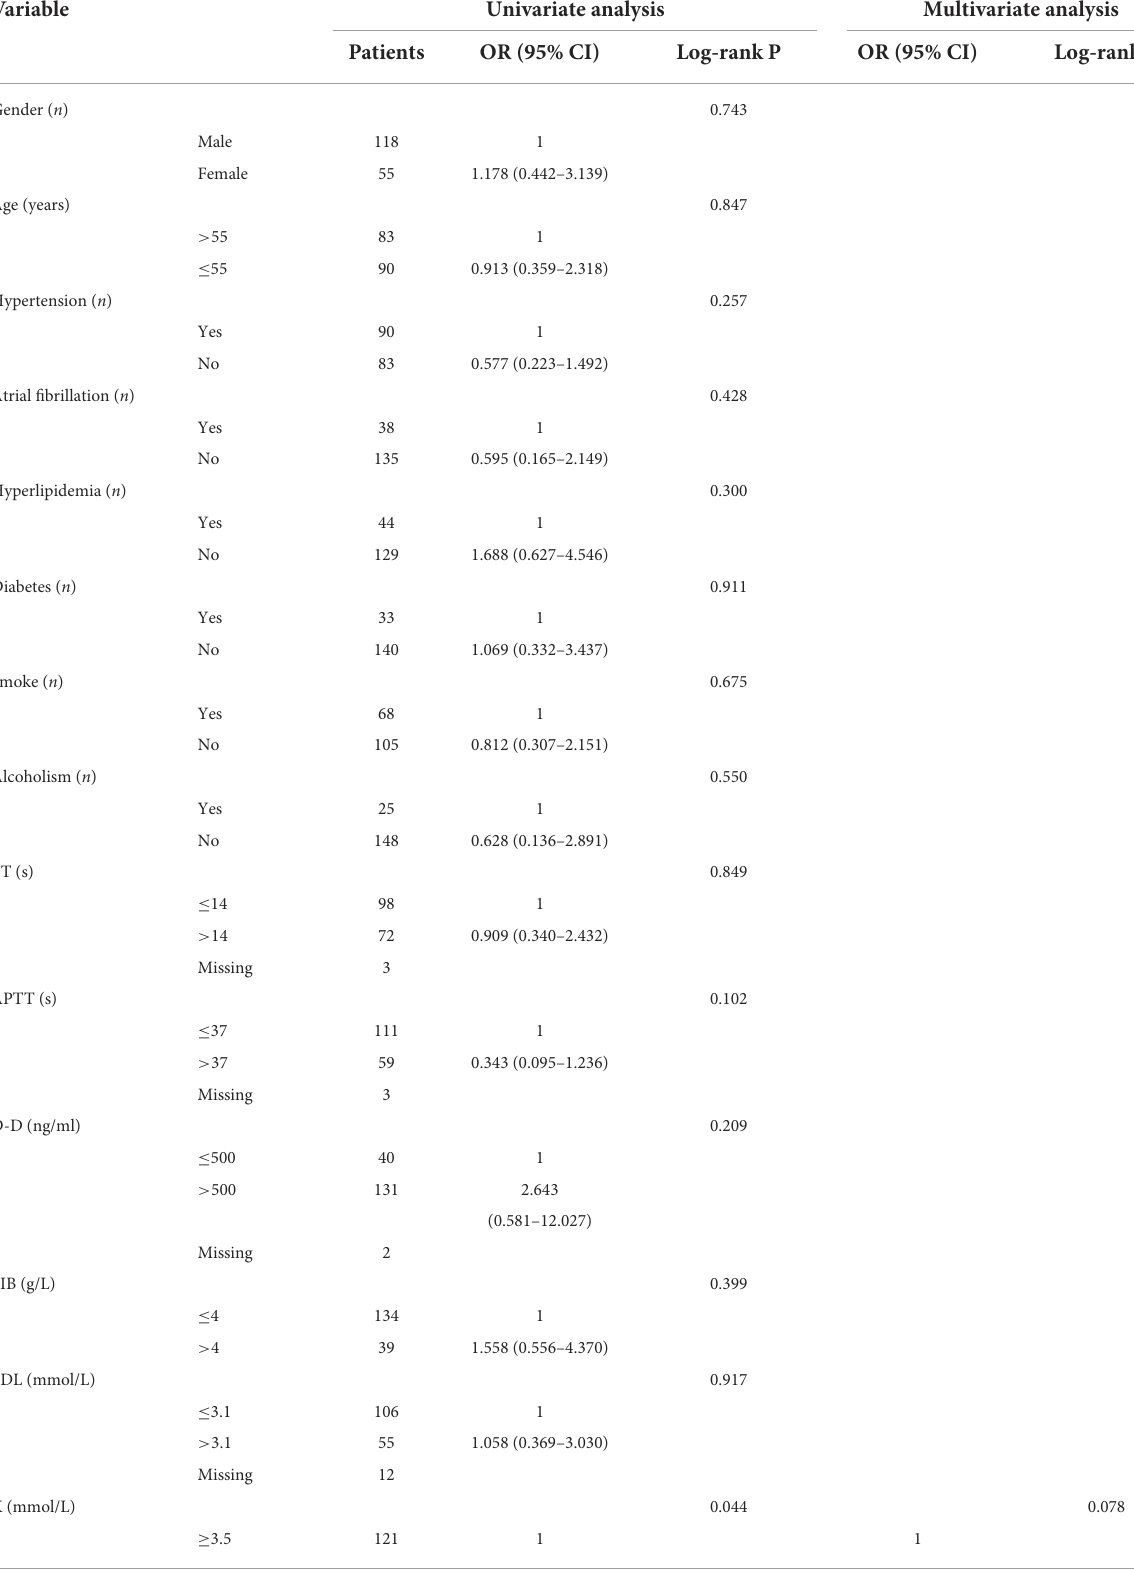
TABLE 2 Binary logistic regression analysis predicting outcome.